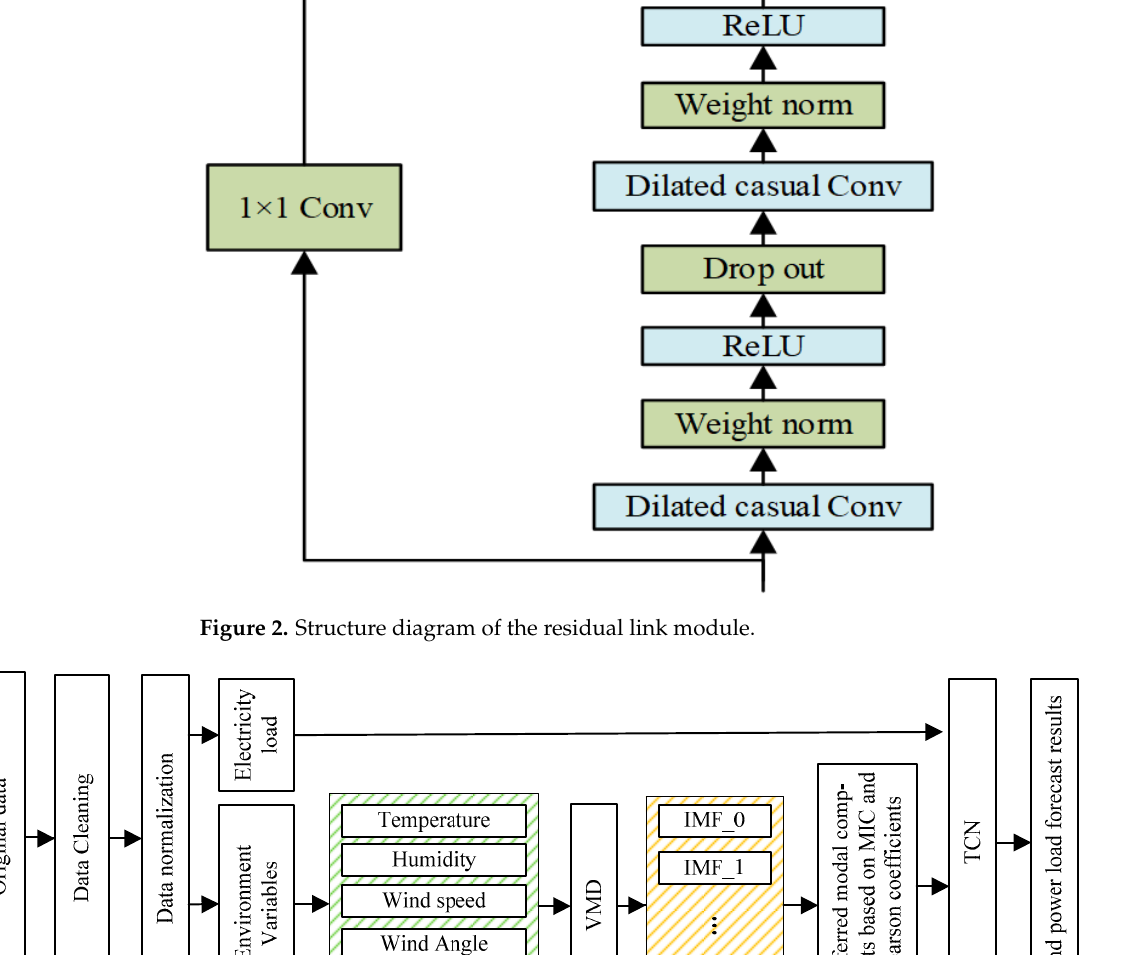
Figure 2. Structure diagram of the residual link module.